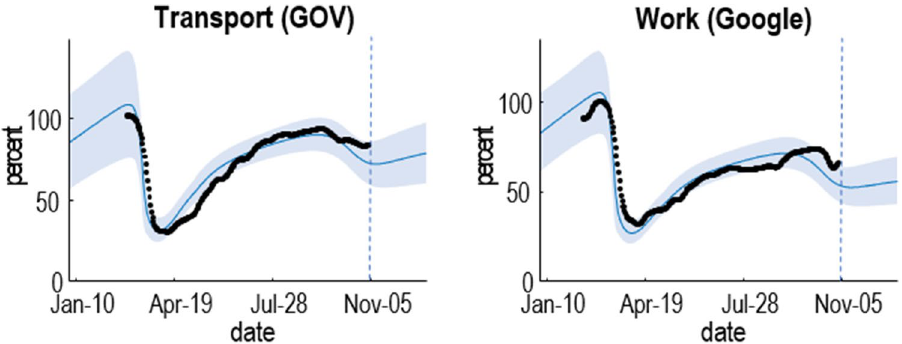
Figure 2. Posterior predictions for mobility. This figure uses the same format as Fig. 1. In this case, the data are expressed as a percentage of pre-pandemic values; namely, transport use and workplace activity, as estimated from Google mobility data. Please see main text for the data